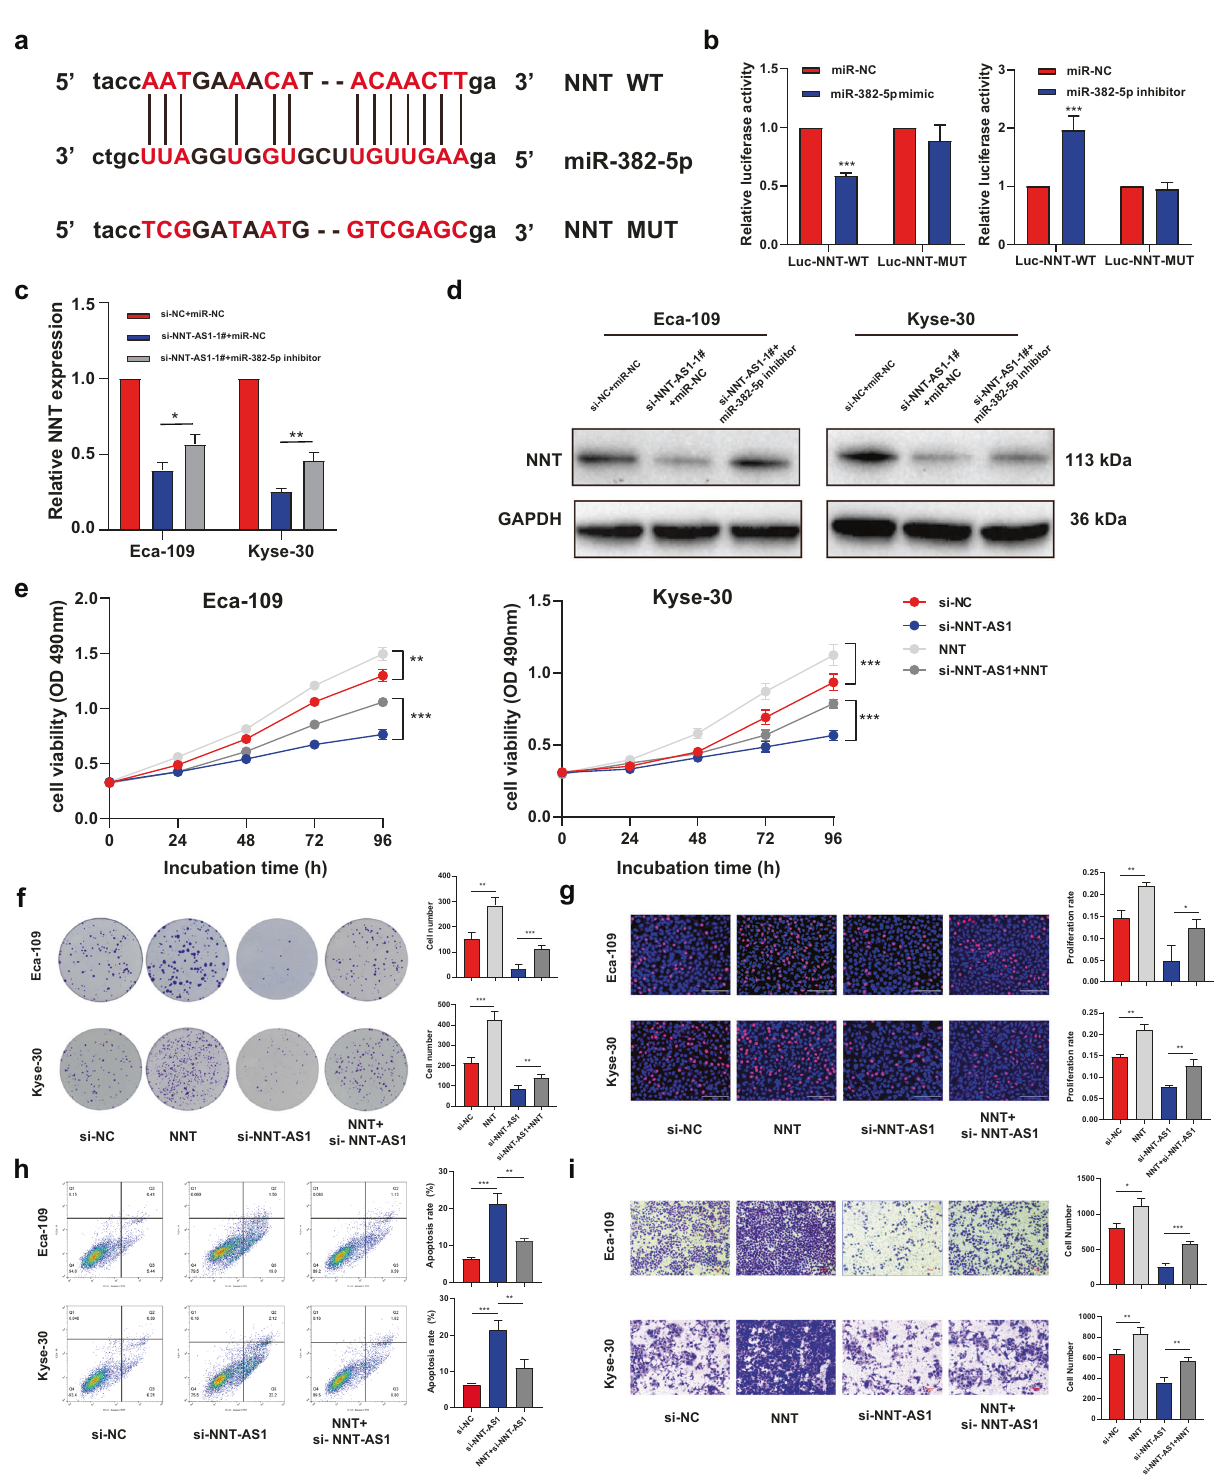
Fig. 6 MiR-382-5p negatively regulated NNT and overexpression of NNT rescued the decline of cellular function that NNT-AS1 knockdown mediated in ESCC. a MiR-382-5p had a binding site for NNT; b Dual-Luciferase assays were utilized to detect the luciferase activities in Eca-109 cells after being co-transfected with miRNAs (miR-NC, miR-382-5p mimics, miR-382-5p inhibitor) and luciferase reporter vectors (NNT- WT and NNT- MUT) respectively; c , d downregulation of miR-382-5p rescued the decreased NNT expression mediated by NNT- AS1 inhibition in Eca-109 and Kyse-30 cells; e – i Rescue assays were conducted to measure the cellular functions of NNT-AS1 knockdown cells after overexpressing NNT in Eca-109 and Kyse-30 cells. The results were from three independent experiments. Data were analyzed by unpaired Student ’ s t -test. *** P < 0.001, ** P < 0.01, * P < 0.05. Variables were presented as the Mean ±